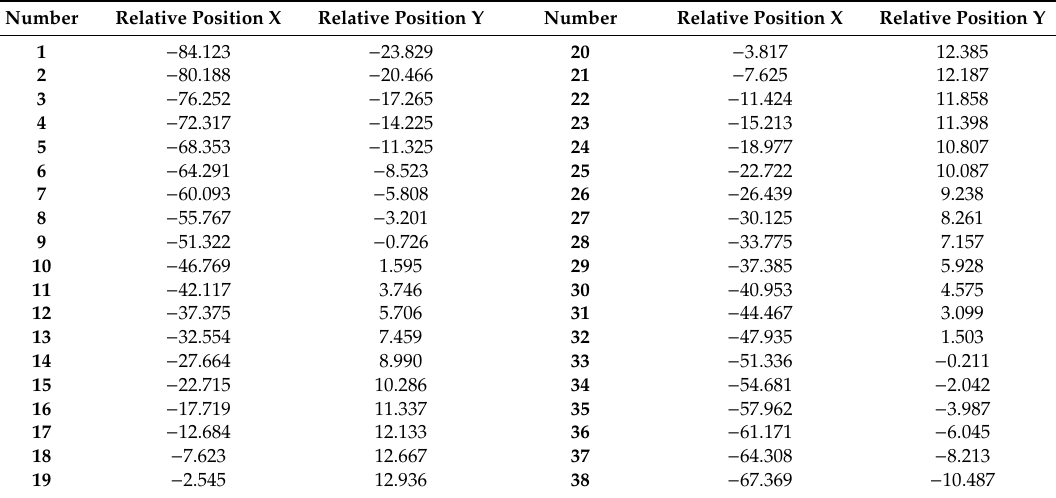
Table 2. Abrasive belt grinding track target